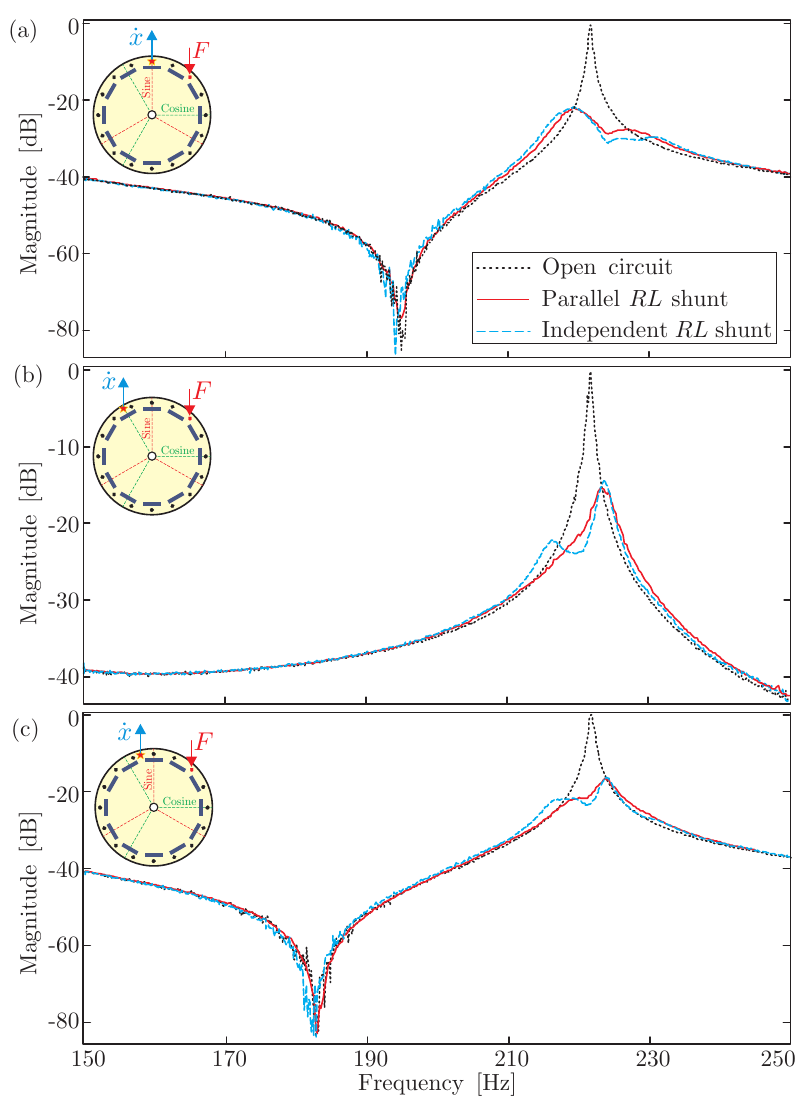
Figure 9. Experimental results: comparison between the independent shunt and parallel shunt for the first mode with n = 3 nodal diameters. The dotted lines correspond to the original system with a natural damping of 0.05%. ( a ) ˙ x is measured at the point where the sine mode is maximized. ( b ) ˙ x is measured at the point where the cosine mode is maximized. ( c ) ˙ x is measured in the middle where both modes contribute to the